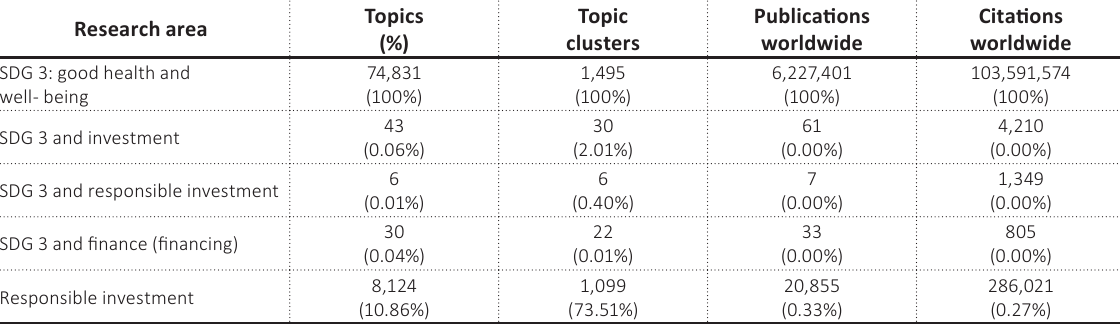
Table 2. Static analysis of SDG 3 and investment coverage in academic literature over the